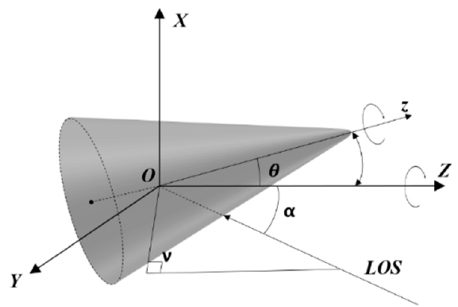
Figure 13. Geometry of the cone-shaped target.